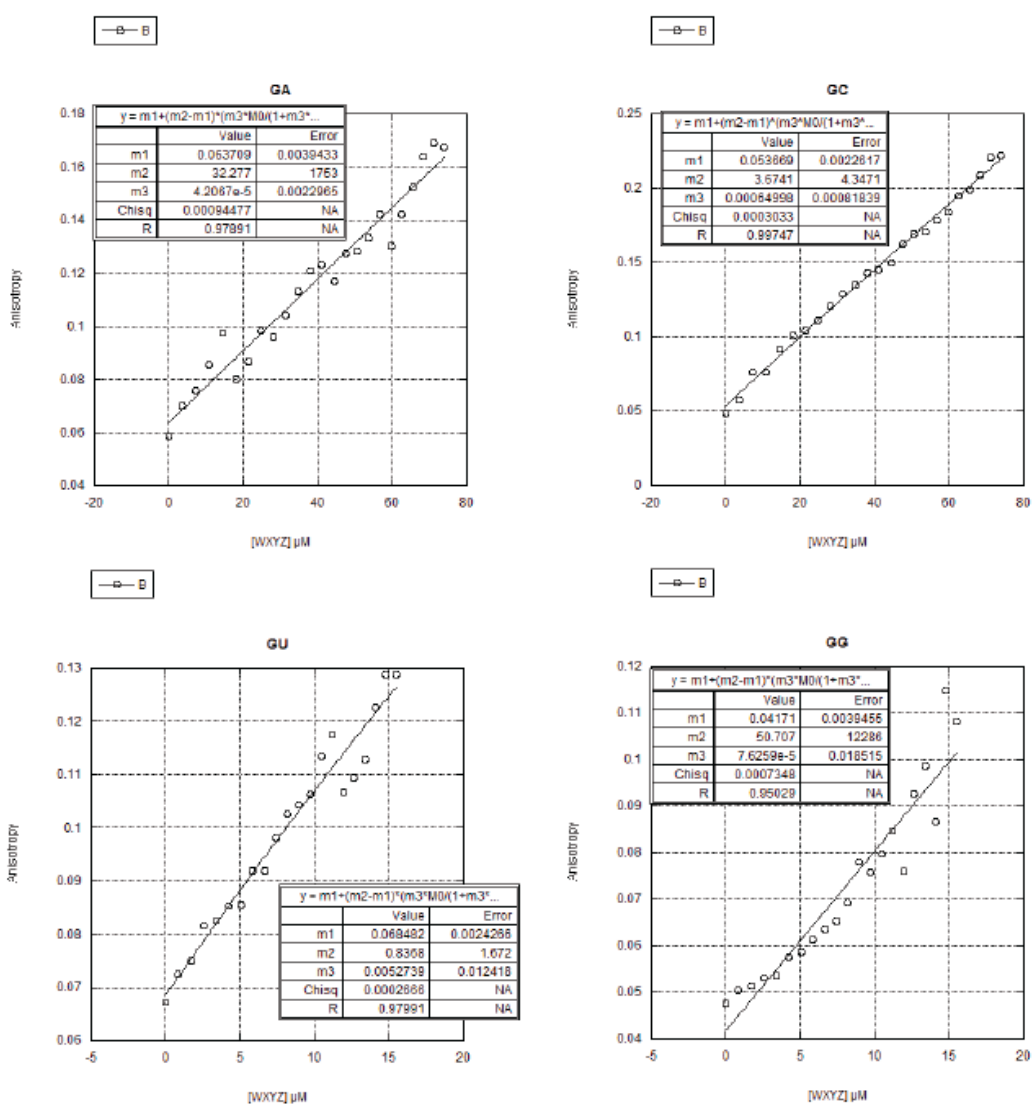
Figure A4. Raw anisotropy data for IGS-tag combinations where the middle nucleotide of the IGS is G. None of these plots show a saturation in polarization as RNA concentration increases, indicating an RNA-RNA aggregation phenomenon for ribozymes with the GGG IGS (see text).